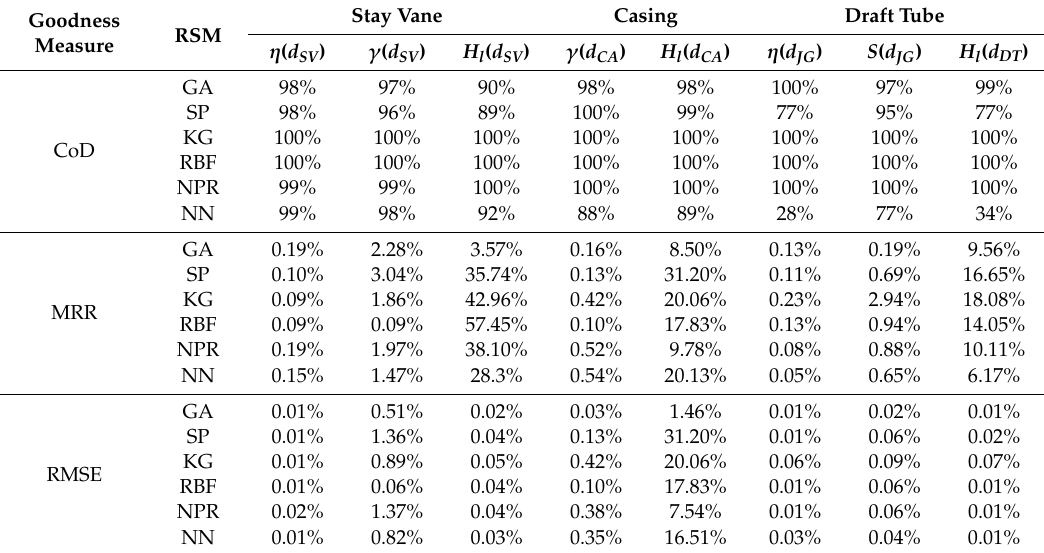
Table 2. Results of goodness of fit test. (CoD is Coe ffi cient of Determination, MRR is Maximum Relative Residual, RMSE is Root Mean Square Error).